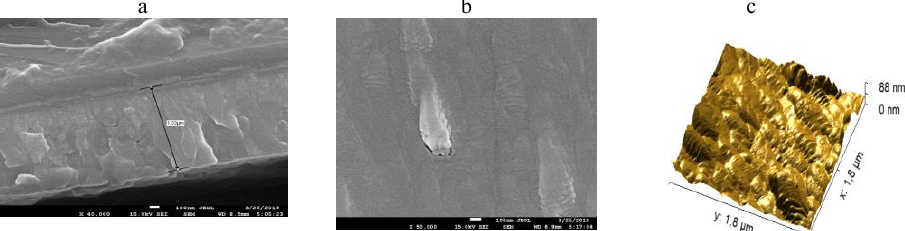
Fig. 2. SEM-image of the cross-section (a) and the surface (b) of the M-coating on the Si substrate. AFM image of the M-coating surface on Si (c). The working pressure of the gas mixture Ar + CO 2 — 0.1 Pa